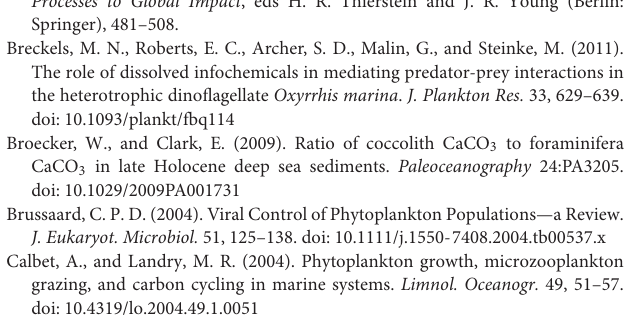
Supplementary Figure 1 | Functional response of O. marina to different prey concentrations of calcified (blue) and decalcified (red) E. huxleyi . In a